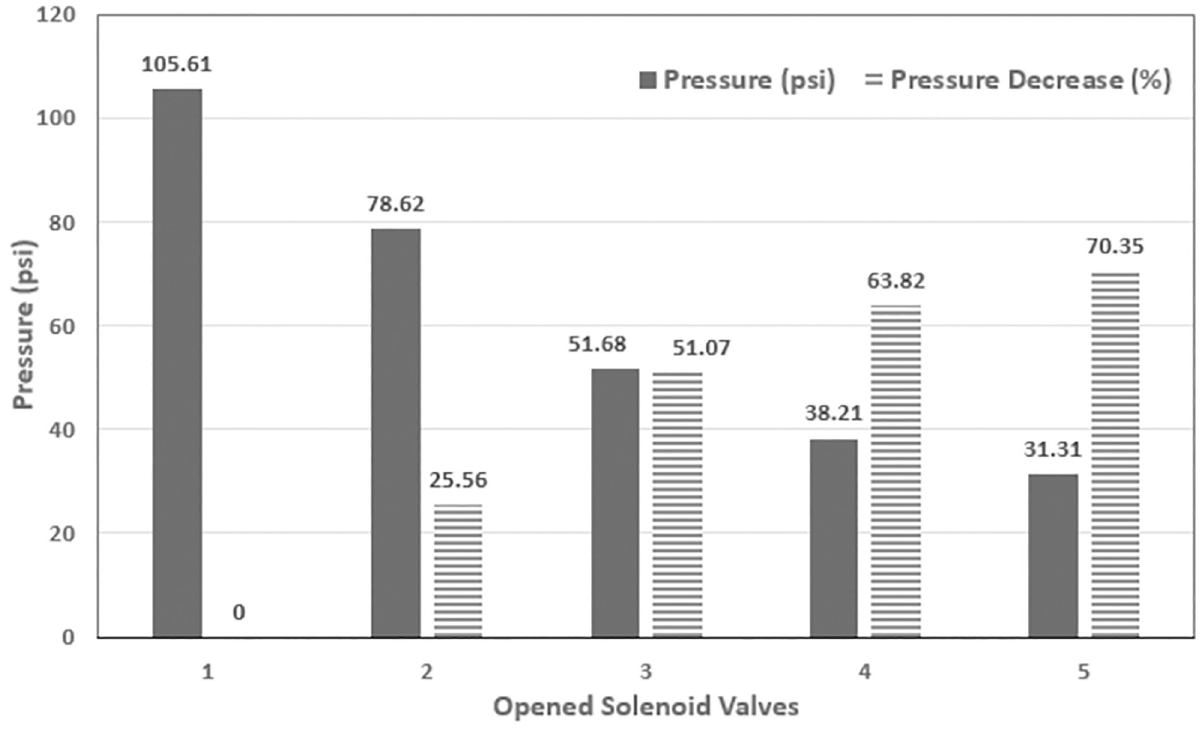
Fig 5. Pressure response with varying numbers of active SVs.